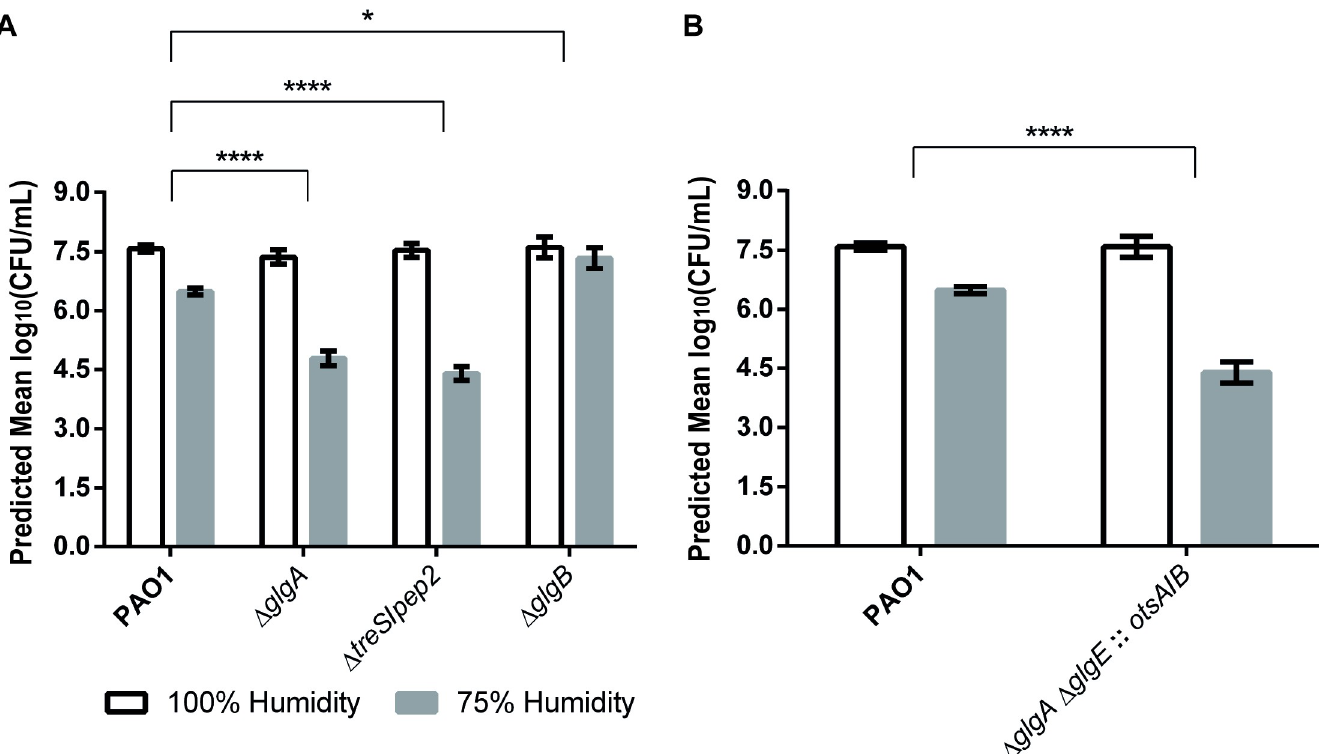
Fig 9. Survival of PAO1 mutant strains subject to desiccation stress conditions. Graphs show predicted mean log(CFU/ml) for strains grown in 100% (white bars) or 75% (grey bars) relative humidity. The response to desiccation is the difference log(CFU/ml) at 100% and 75% RH. P-values for differences between strains’ responses were calculated by linear mixed modelling to account for the multiple levels of random variation in biological and technical replicates and are shown with asterisks ( � : 0.05 > p > 0.01, ���� : p < 0.0001). Responses were tested in at least two independent biological replicates on different dates. A) Strains lacking GlgE-derived α -glucan ( Δ glgA , Δ treS/pep2 ) are desiccation sensitive. Glucan branching (by GlgB) is not required for desiccation tolerance. B) Recovery of trehalose synthesis by otsA/ B expression cannot recover desiccation tolerance in a Δ glgA/E ( α -glucan minus)